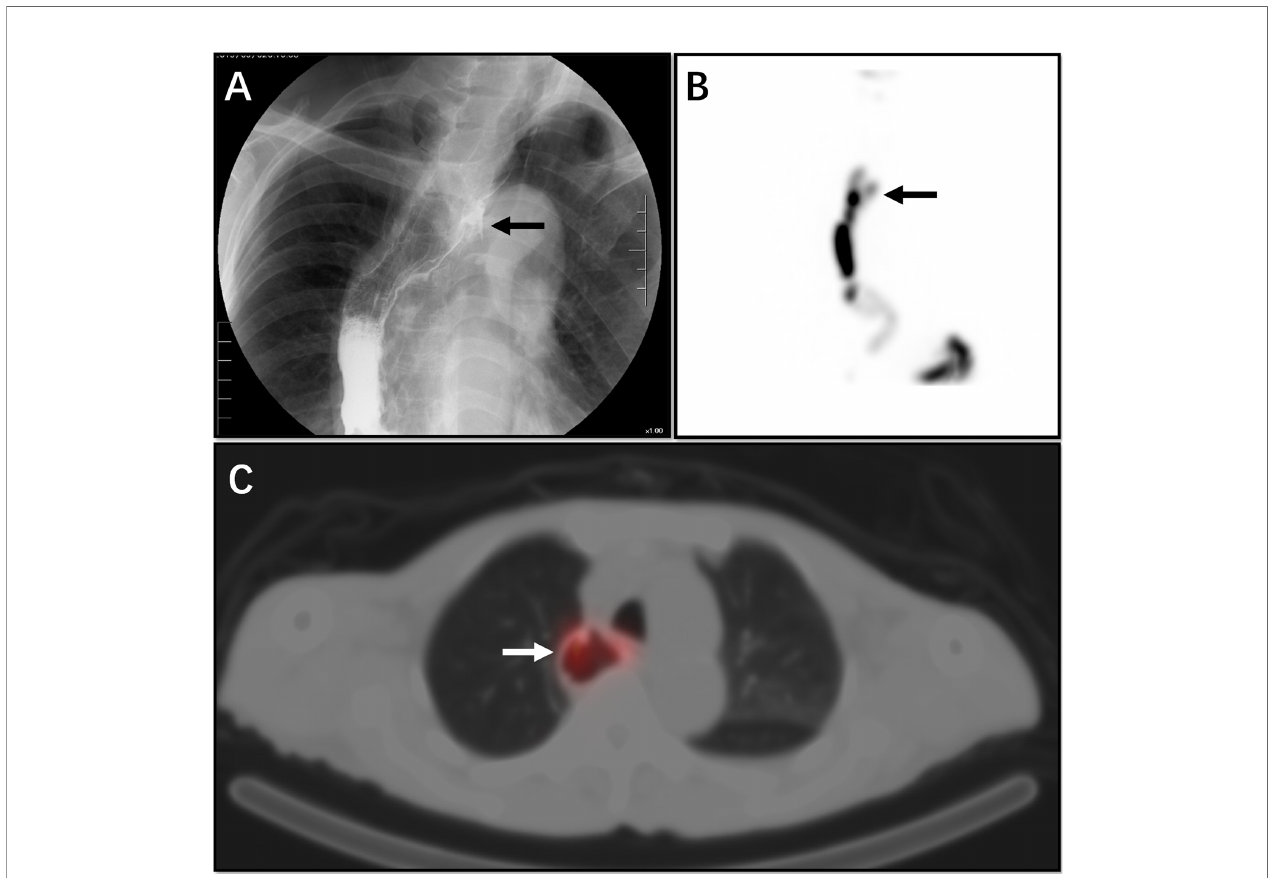
FIGURE 4 | This 53-year-old male patient had a partial oesophageal resection due to an oesophageal tumour. The patient had a VFSS examination, which suggested an upper oesophageal fi stula ( A , arrow). The patient also underwent salivagram. From the MIP image, we see a small concentration of imaging agent outside the lumen of the upper oesophagus ( B , arrow). On tomographic fusion imaging, we see that the abnormality represents a diverticulum at the anastomosis of the oesophagus ( C , arrow) rather than an oesophageal fi